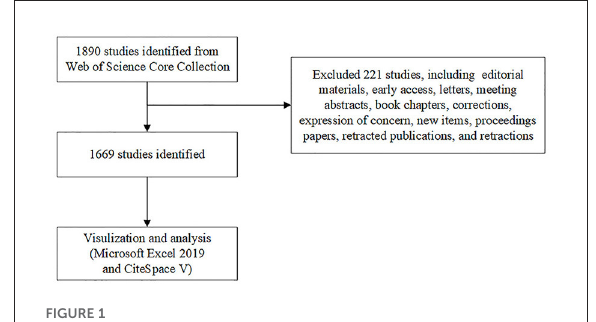
FIGURE1 Flowchart of literature